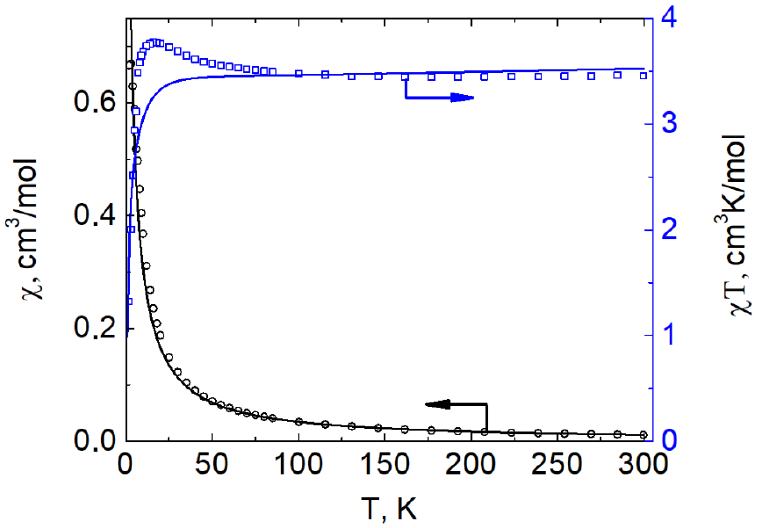
Figure 3. Experimental χ m vs. T (black circles) and χ m T vs. T (blue squares) dependences for the complex 1 under 5000 Oe dc-field and corresponding theoretical curves calculated using the results of the SA-CASSCF(6,10)/NEVPT/SOC-QDPT calculations for 5 quintet and 45 triplet states.